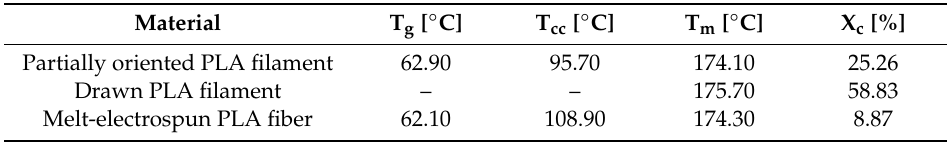
Table 3. Properties of PLA fibers, comparing partially orientated and drawn filaments with melt-electrospun fibers.